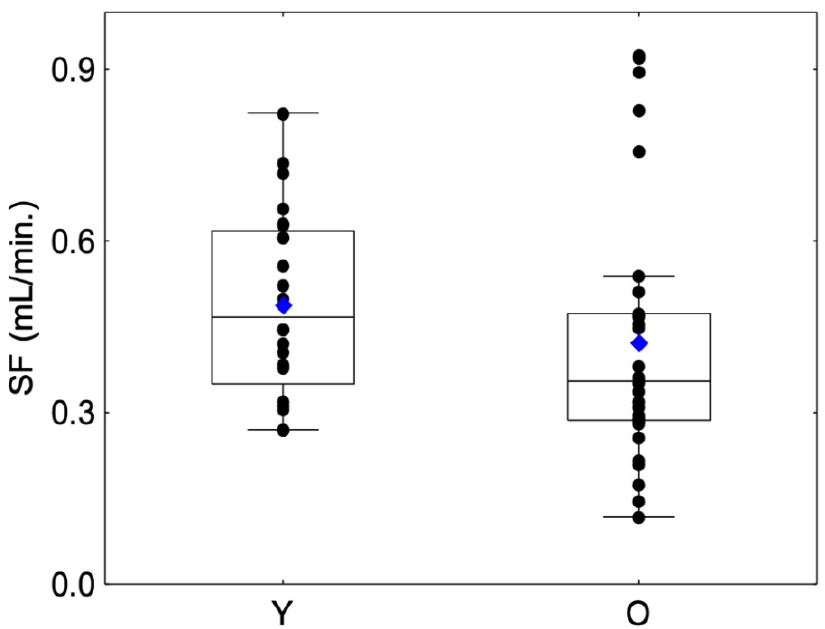
Figure 2. Box-plot distributions of whole salivary flow (SF) as a function of the age category (young (Y) and elderly (O)) are shown. The bottom and top of the box correspond to the 25th and 75th percentiles, respectively. The horizontal band and the blue diamond correspond to the median and the mean, respectively. The ends of the whiskers represent the nonoutlier range. The black dot sym- bols correspond to individual data points.